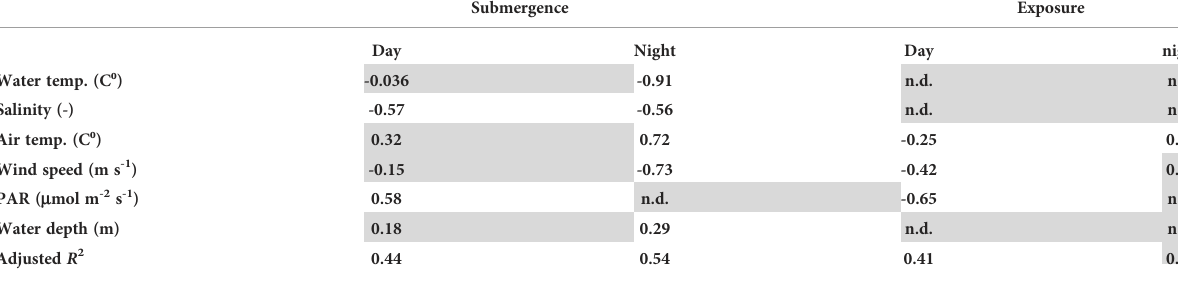
TABLE 1 Partial regression coef fi cients between the predictor variables and atmospheric CO2 exchange.